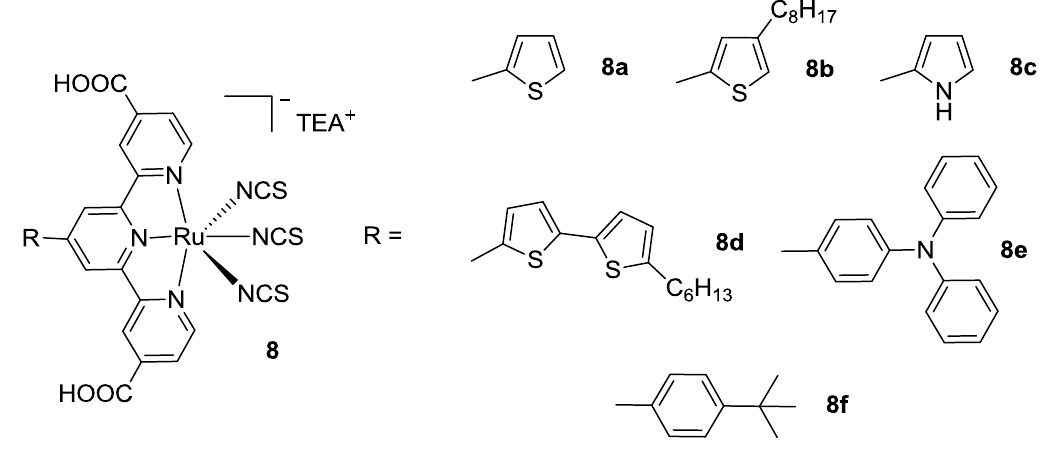
Figure 10. 4’ substituted Black Dye analogs [80].